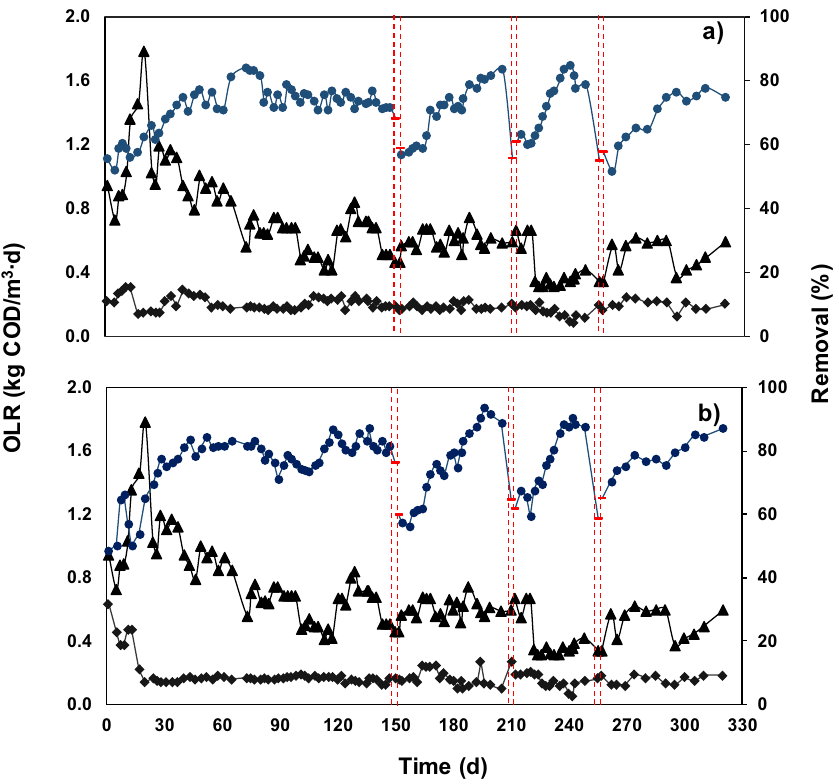
Figure 2. Removal efficiency of organic load rate (OLR) (kg COD/m 3 ∙d) with UASB effluent. Where: ( a ) is R1 with polyurethane foam and ( b ) is R2 with polyethylene rings. (filled circle) Removal of chemical oxygen demand (COD) percentage; (filled triangle) influent and (filled diamond) effluent. Lines show days in which nitrifying and denitrifying activities were performed in both discontinuous